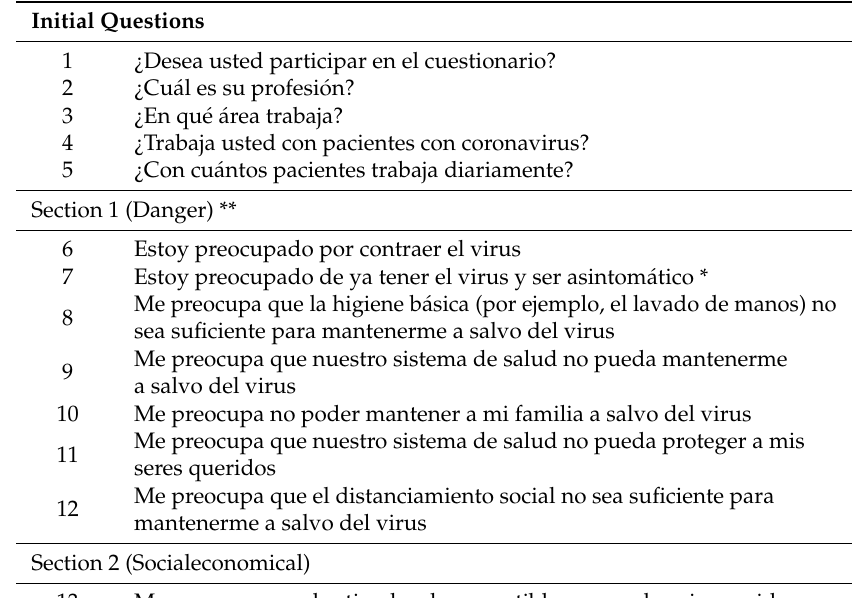
Table 1. Structure and adaptation of the COVID-19 stress scales (CSS) [26] for Spanish-speaking healthcare